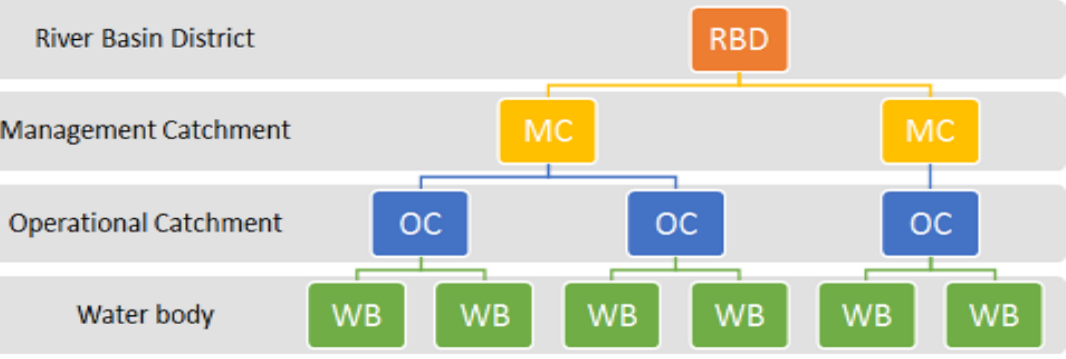
Figure 4. The hierarchy adopted by the Catchment Based Approach [68].